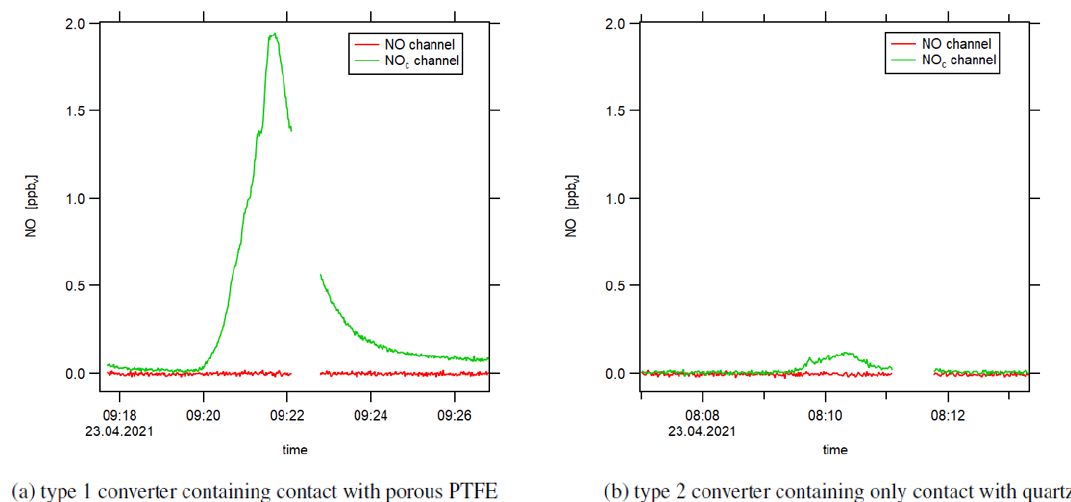
Figure 7. Instrumental background (zero air measurement) when heating the switched-off photolytic converter with a heat gun. The small data gaps are due to pre-chamber measurements.